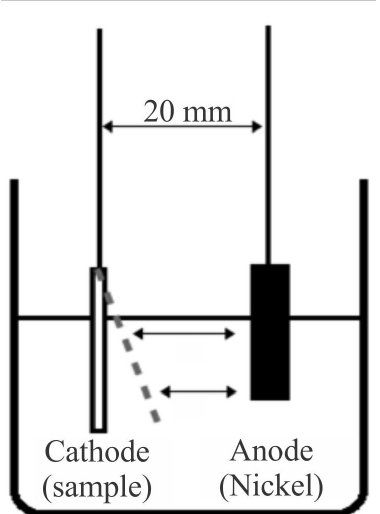
Figure 1. Influence of the cathode position on the thickness of the coatings.